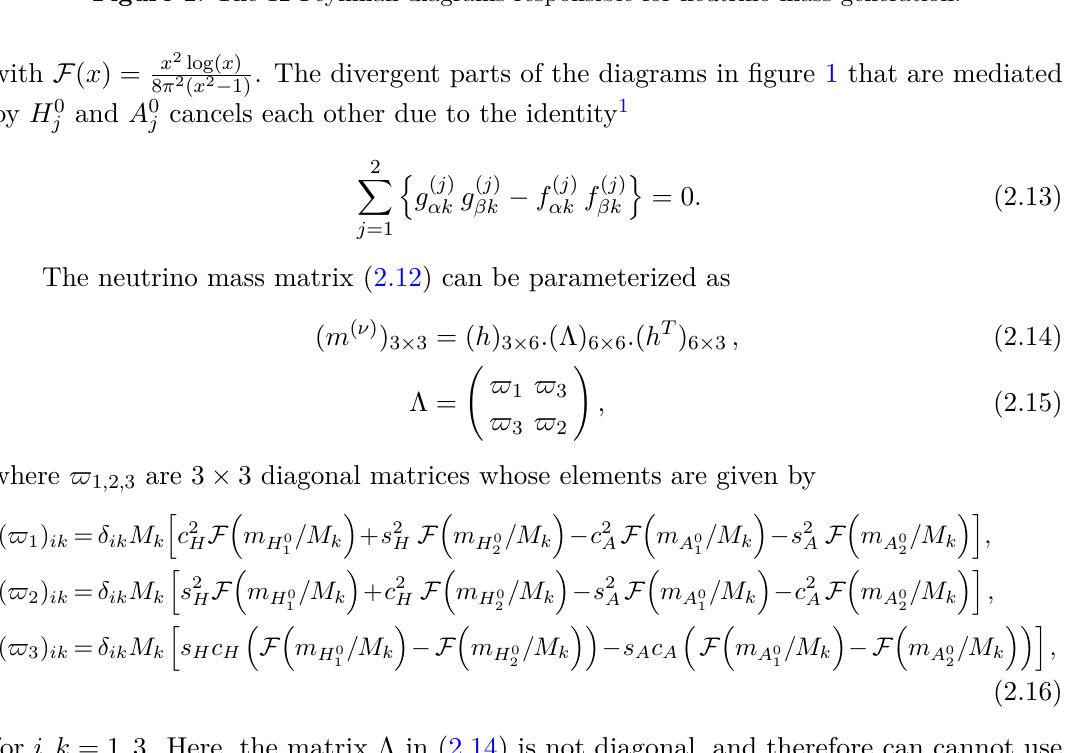
Figure 1 . The 12 Feynman diagrams responsible for neutrino mass